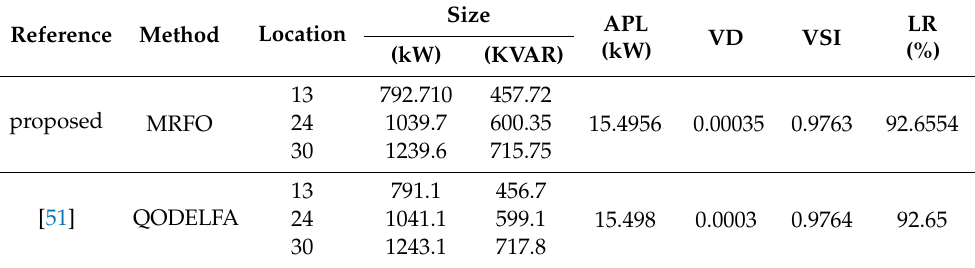
Figure 16. Characteristics of VSI, 33-bus system 0.866pf.